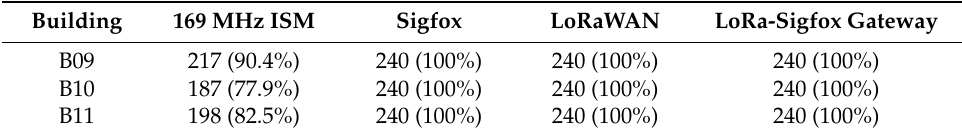
Table 3. Reception rates over a period of 10 days (240 samples) with each of the different systems tested in a water-meter with a percentage of received samples ranged higher than 75% over expected in the 169 MHz ISM band.